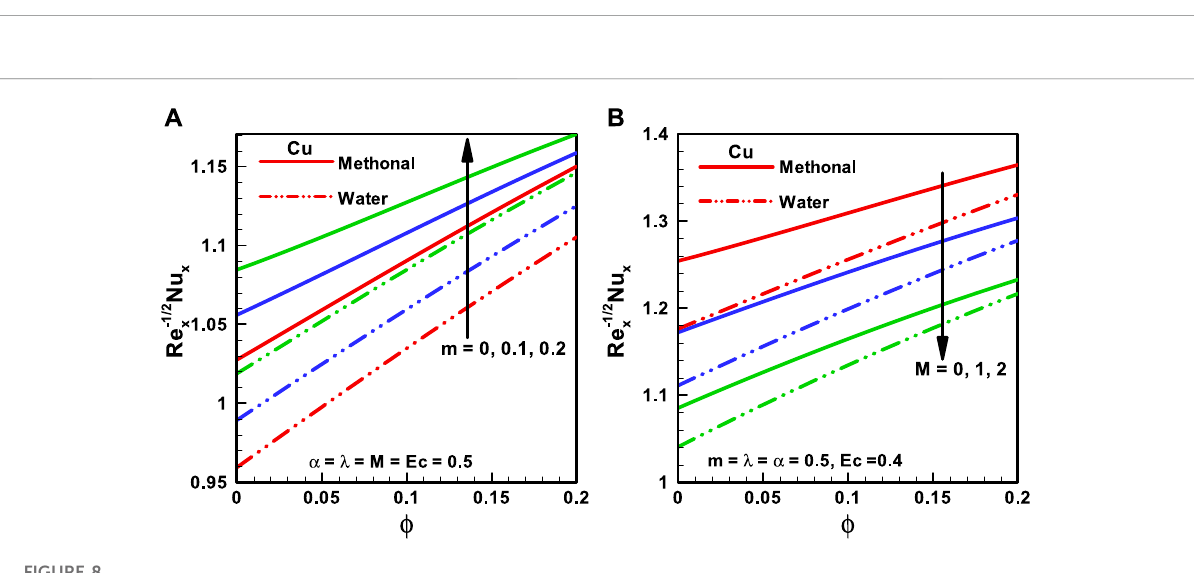
FIGURE 8 (A,B) Nusselt number corresponding to different base fl uids, that is, water and methanol for (A) wedge parameter ( m ) and (B) Hartmann number ( M